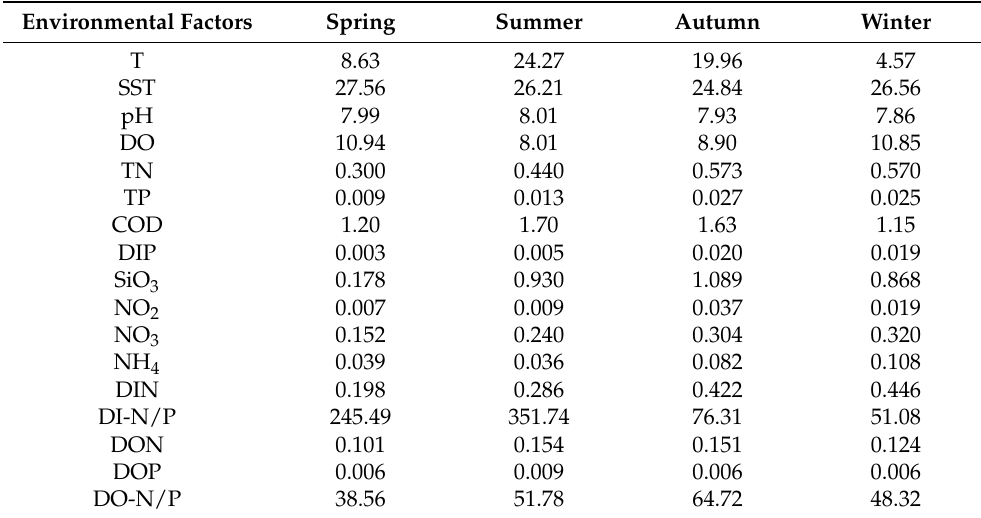
Table 4. The average values of environmental parameters for each season in 2020 and 2021. Environmental Factors Spring Summer Autumn